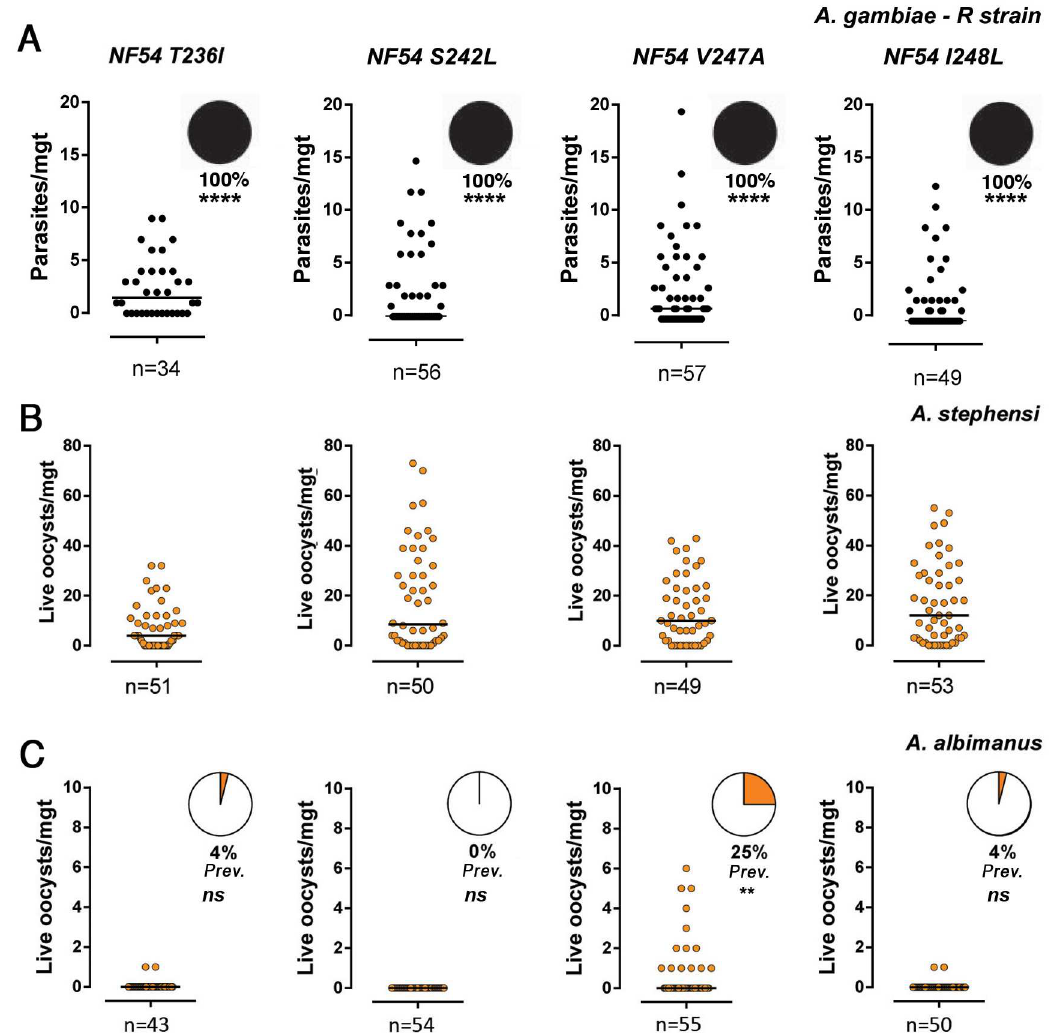
Fig 3. Infection phenotype of different Pfs47 complement P . falciparum lines (T236I, S242L, V247Aand I248L) in the A . gambiae R strain, A . albimanus and A . stephensi 7–9 d post-feeding representing two pooled independent experiments (Experiment 1 and Experiment 2, S1–S3Tables). (A) Infection of A . gambiae R strain. The pie charts indicate the proportionof live (orange)and melanized(black) parasites. (B) Infection of A . stephensi Nijmegen, and (C) A . albimanus mosquitoeswith P . falciparum NF54 Pfs47KO complemented derivativesexpressing Pfs47 haplotypes NF54 T236I, S242L, V247A and I248L. The orangearea of the pie charts indicates the prevalenceof infection in A . albimanus . Each dot represents the numberof parasite on an individual mosquitoand the medianis indicatedwith a black line (n = numberof midguts examined). Melanization prevalences in A . gambiae R strain were comparedwith the X 2 test relative to Pfs47 KO + NF54, infectionprevalences in A . albimanus were comparedwith the X 2 test, ns = no significant difference, ** p < 0.01, **** p < 0.0001.All parasite phenotypes were confirmedin two or three independent